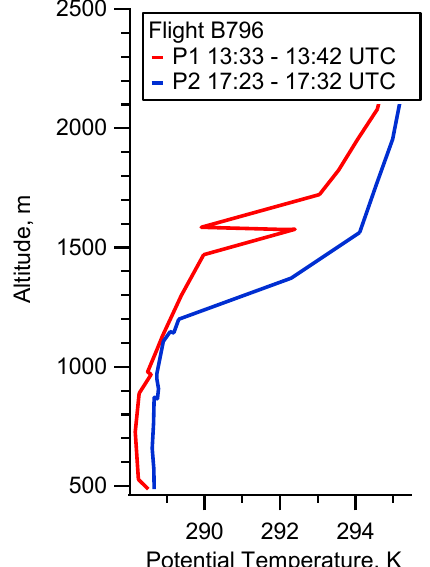
Figure 1. The potential temperature change experienced by changing altitude during flight B796b’s profile ascent (P1) at time 13:33–13:42 UTC and the profile descent (P2) at time 17:23–17:32 UTC identifying clear temperature increases at 1460 and 1200 m, respectively.